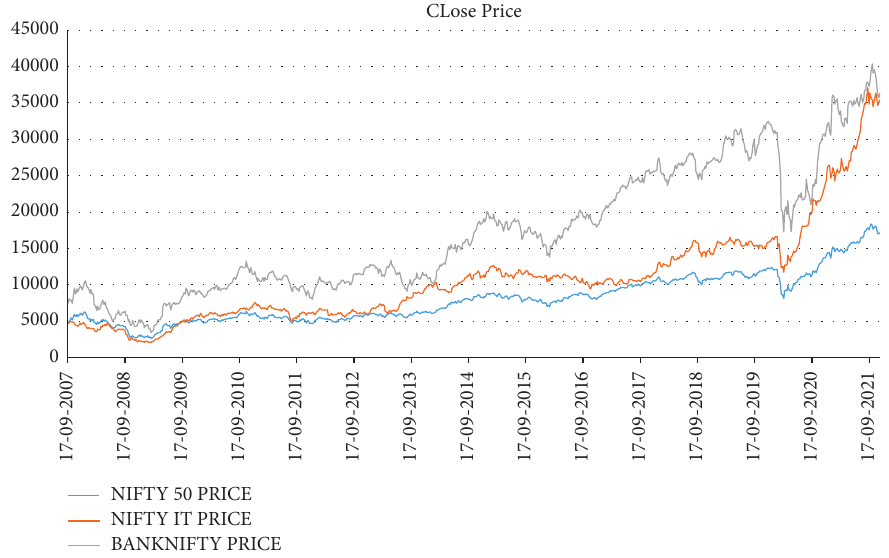
Figure 3: NSE indices.